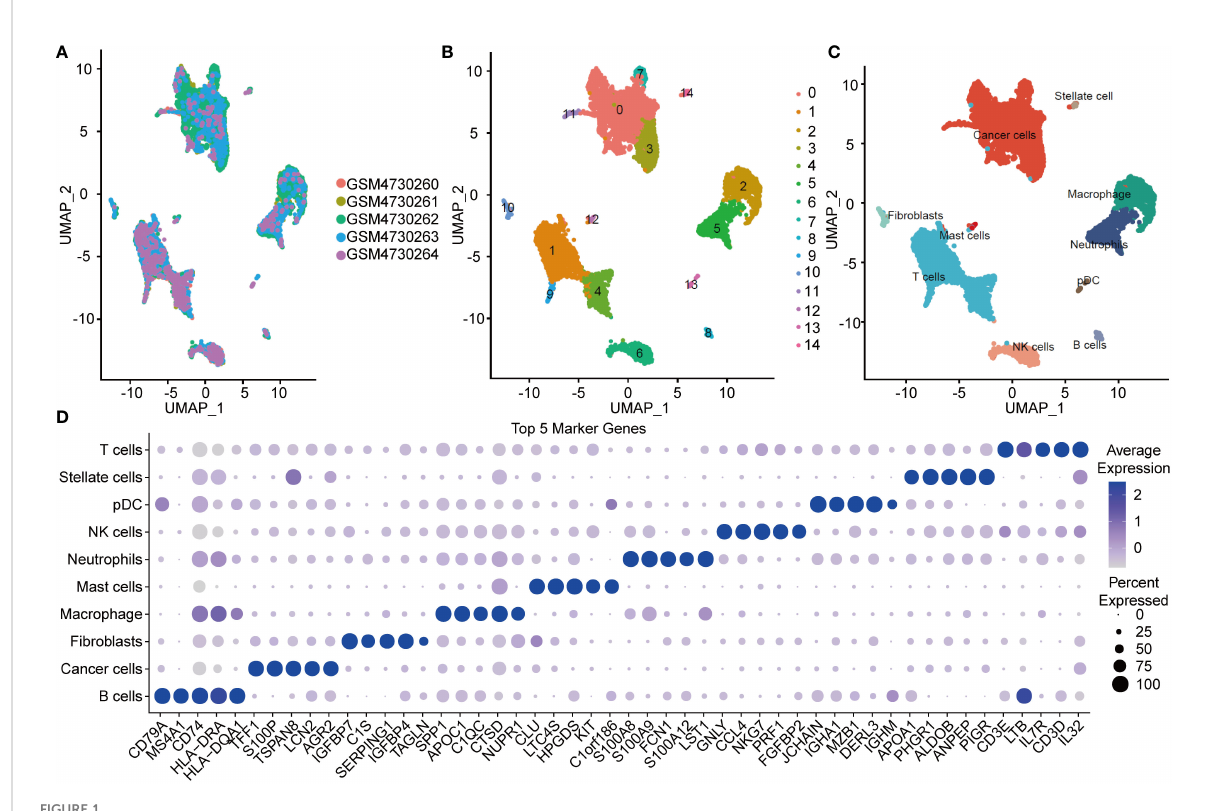
FIGURE 1 UMAP plot and maker genes of cell population. (A) UMAP plot of SCS in fi ve samples. (B) UMAP of the 14 subgroups after clustering. (C) UMAP of subpopulation after cell annotation. (D) Top fi ve marker genes in the cell